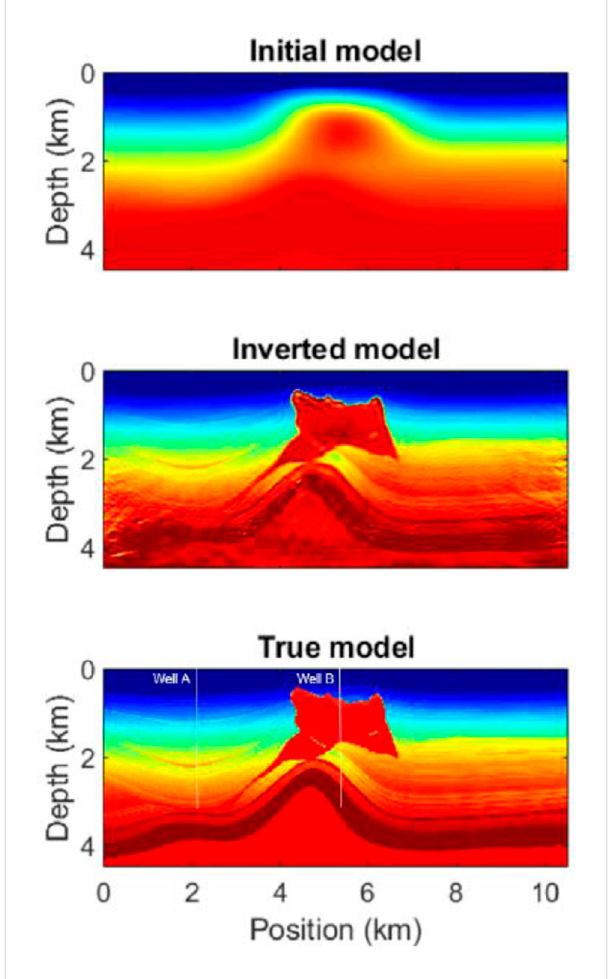
FIGURE 7 Initial model, inverted model, and true model. As can been seen, the shapes of the salt as well as detailed layered structures are well inverted compared with the true velocity model. Two validation wells are also demonstrated in the true